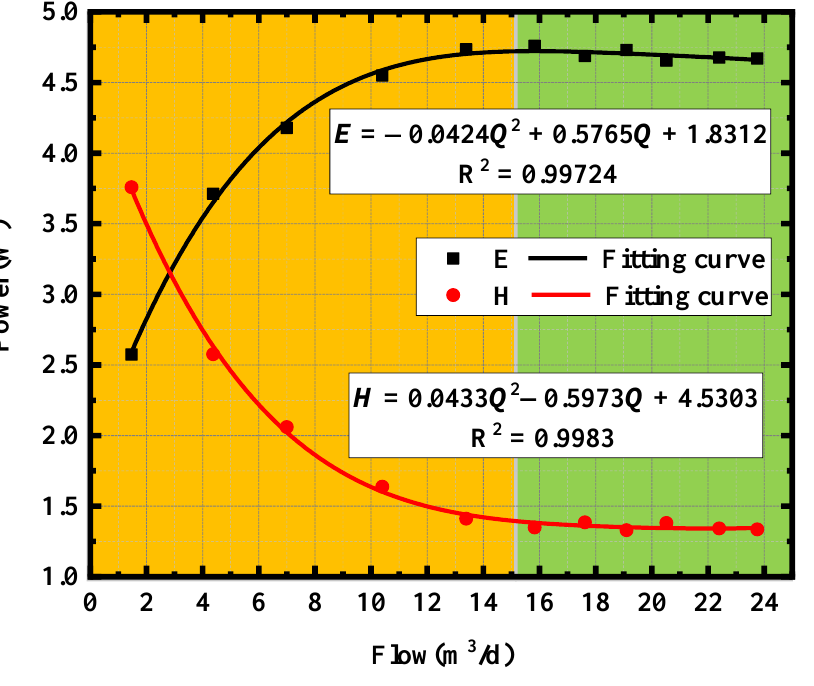
Figure 9. Diagram of power and flow.